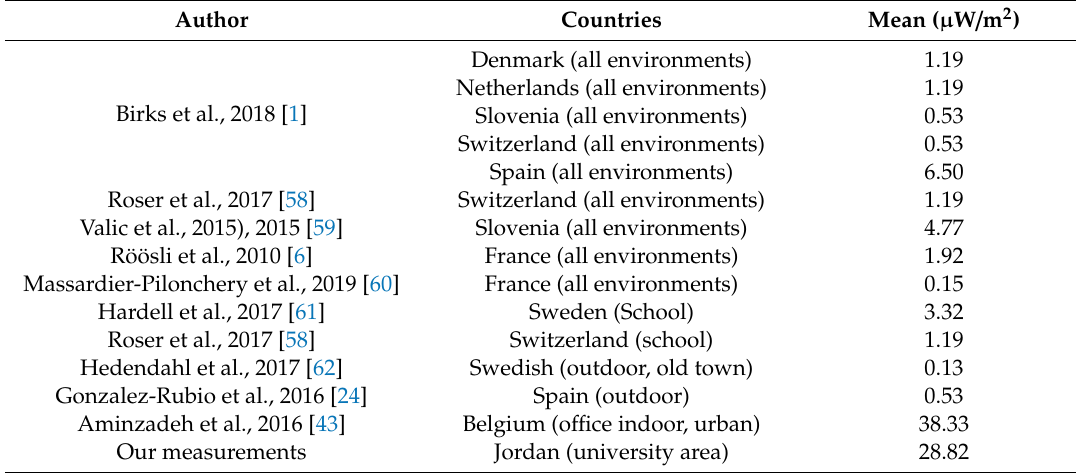
Table 6. Results of some reviewed studies that considered measurements of the Wi-Fi frequency band ( µ W / m 2